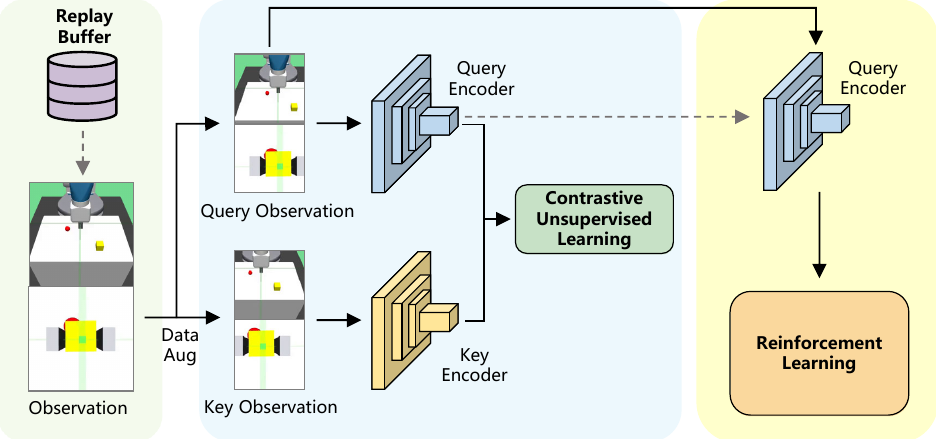
Figure 1. Architectural overview. A pair of observations are sampled from the replay buffer, and observations are then transformed into query and key observations by data augmentation. The data- augmented observations are encoded with the query and key encoders, respectively, for pretraining the encoder with contrastive unsupervised learning. The query encoder with initialized parameters is continually updated to train the agent in RL algorithm with data